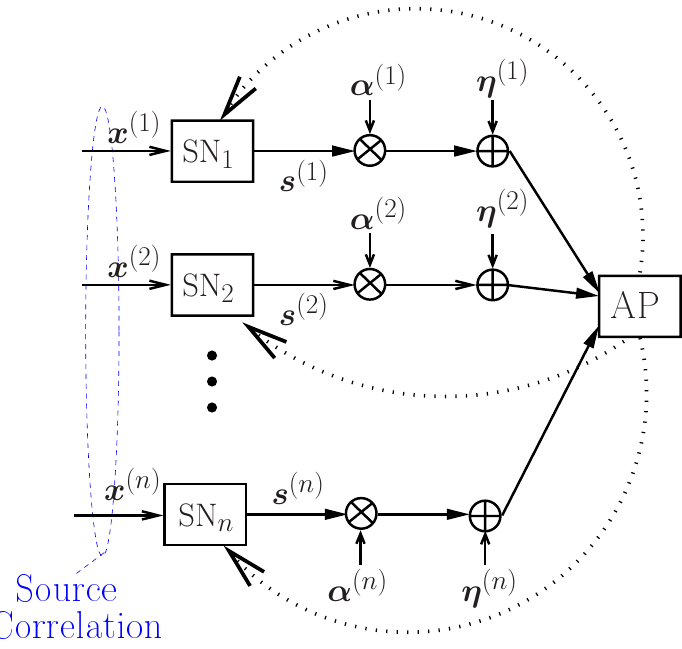
Figure 1. Multiple access scheme with